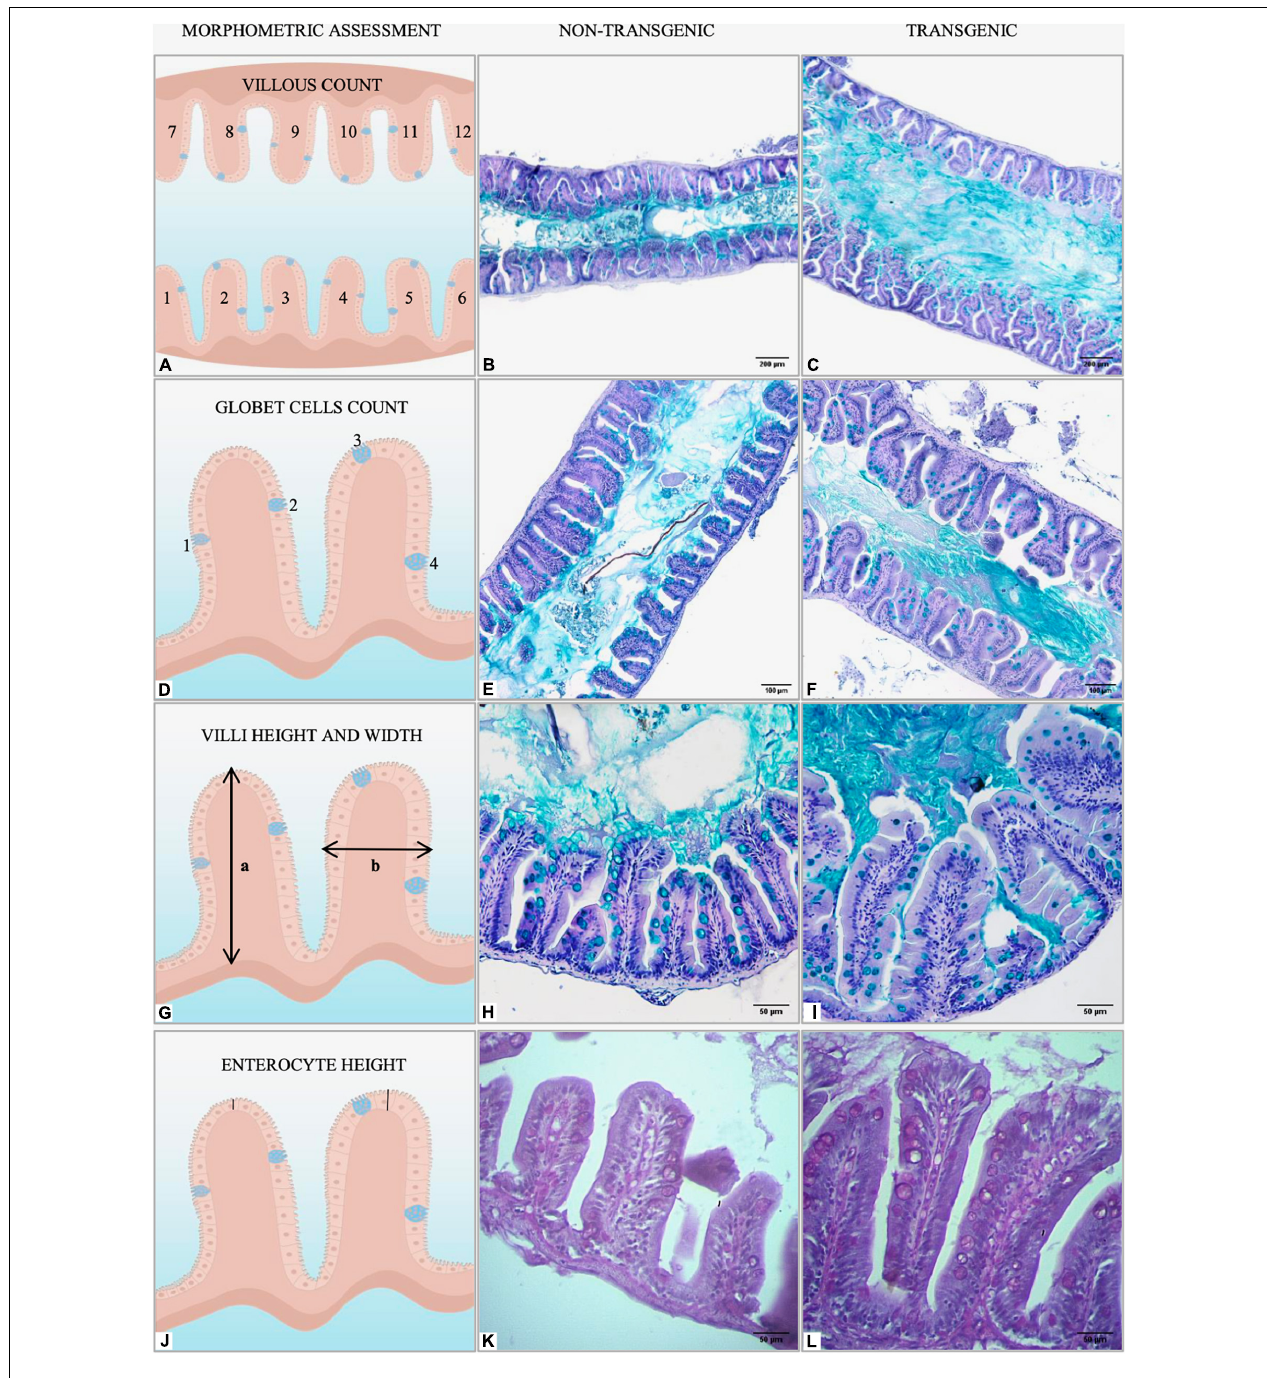
FIGURE 2 | Graphical representation of morphometric analysis performed in the intestine of non-transgenic and gh -transgenic zebrafish ( D. rerio ) siblings. (A) Intestinal folds were manually counted in six fields randomly sampled for each animal using the multipoint tool from ImageJ. Representative Alcian blue-stained sections of midgut cross-sections from (B) non-transgenic and (C) gh -transgenic zebrafish. Magnification: × 10, scale bar: 200 µ m. (D) The number of intestinal goblet cells was determined by manually counting all cells in six randomly sampled fields for each animal using the multipoint tool from ImageJ. Representative images of midgut sections stained for the goblet cell marker Alcian blue from (E) non-transgenic and (F) gh -transgenic zebrafish. Magnification: × 20, scale bar: 100 µ m. (G) Intestinal villus height (a) and width (b) were manually measured in the anterior and middle intestine from 24 individual villi randomly sampled for each animal using the segmented line tool from ImageJ. Representative Alcian blue-stained sections of anterior intestine from (H) non-transgenic and (I) gh -transgenic zebrafish. Magnification: × 40, scale bar: 50 µ m. (J) Enterocyte height was manually measured in the anterior intestine from 24 individual villi randomly sampled for each animal using the segmented line tool from ImageJ. Representative Periodic acid-Schiff (PAS) stained sections of anterior intestine from (K) non-transgenic and (L) gh -transgenic zebrafish. Magnification: × 40, scale bar: 50 µ m, n = 18 non-transgenic and 18 gh -transgenic zebrafish.